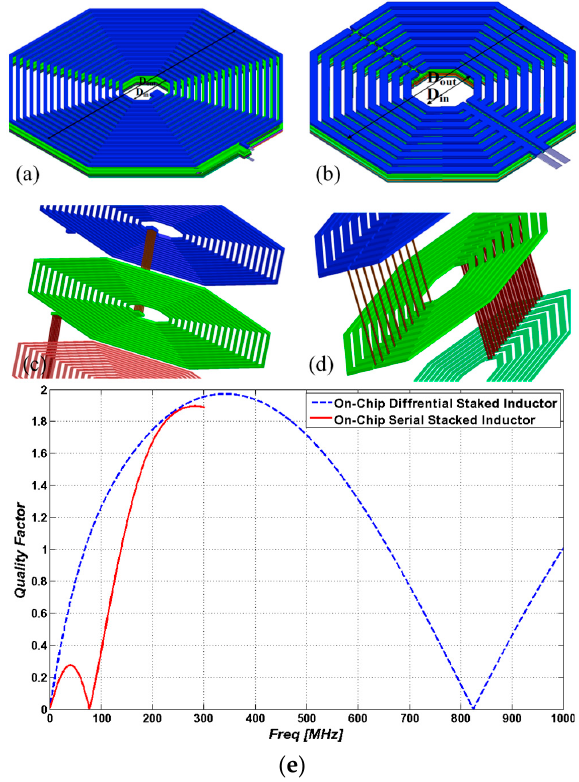
Figure 5. Magnetic field simulation results: ( a , c ) SSC; ( b , d ) DDS and ( e ) quality factor of SSC and DSC.